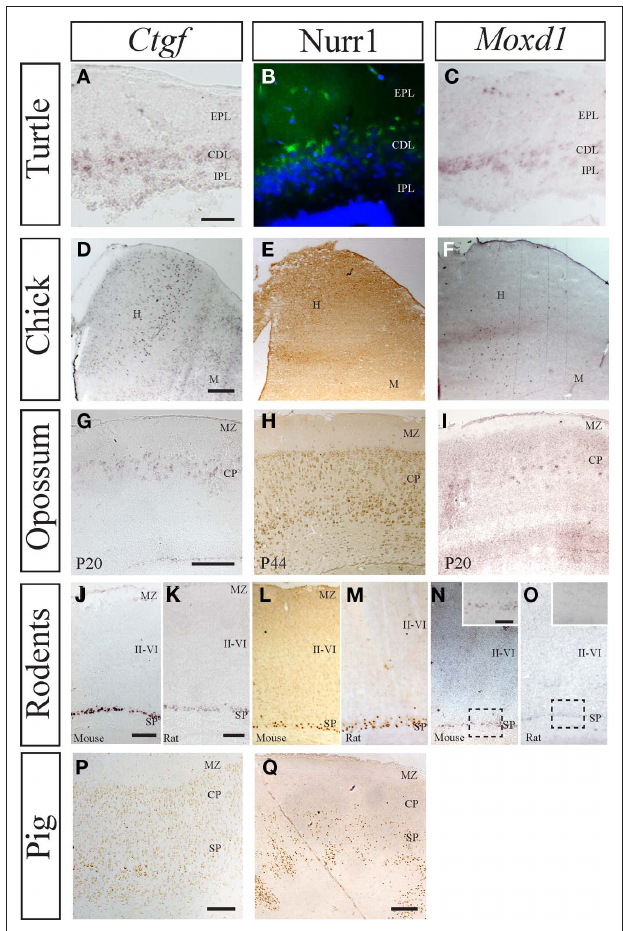
Figure 2 | Comparative expression of murine subplate markers (Ctgf, Moxd1, and Nurr1) in selected species. (A–C) mRNA expression of Ctgf and Moxd1 and protein expression of Nurr1 in the adult turtle, with external plexiform layer (EPL), cell dense layer (CDL), and internal plexiform layer (IPL) indicated. All three murine subplate markers are expressed in the dense cell layer in turtle. (D–F) mRNA expression of Ctgf and Moxd1 and protein expression of Nurr1 in chick dorsal pallium with the hyperpallium (H) and Mesopallium (M) indicated. Ctgf is expressed in a column within hyperpallium while Moxd1 labels scattered cells in the hyperpallium, across columnar boundaries. Similarly, Nurr1 is expressed in the dorsal most tip of the hyperpallium, across several columns, but not along their entire depth. (g–i) mRNA expression of Ctgf and Moxd1 and protein expression of Nurr1 in postnatal opossum cortex with cortical plate and marginal zone indicated. Ctgf and Moxd1 are expressed at in the upper cortical plate at the junction with the marginal zone at P20 while Nurr1 is primarily expressed in the lower cortical plate at P44. (J,K) Protein expression of Ctgf and Nurr1 in the embryonic pig cortex with subplate, cortical plate, and marginal zone indicated. Ctgf protein is localized to a thin band within the subplate, while Nurr1 protein is localized to a thicker band representing the subplate and possibly the lower parts of cortical plate. Nurr1 + cells follow the up and down of the above lying cortical gyri and sulci (at the edges of the image). (L,N,P) mRNA expression of Ctgf and Moxd1 and protein expression of Nurr1 in the postnatal mouse cortex with subplate, layers II–VI, and marginal zone indicated. All three markers are confined to the subplate zone in mice. (M,O,Q) mRNA expression of Ctgf and Moxd1 and protein expression of Nurr1 in postnatal rat cortex with subplate, layers II–VI, and marginal zone indicated. Ctgf and Nurr1 expression is confined to the subplate zone while Moxd1 expression is absent in the rat cortex [see inset in (N) (mouse) and (O) (rat)]. Scale bars =